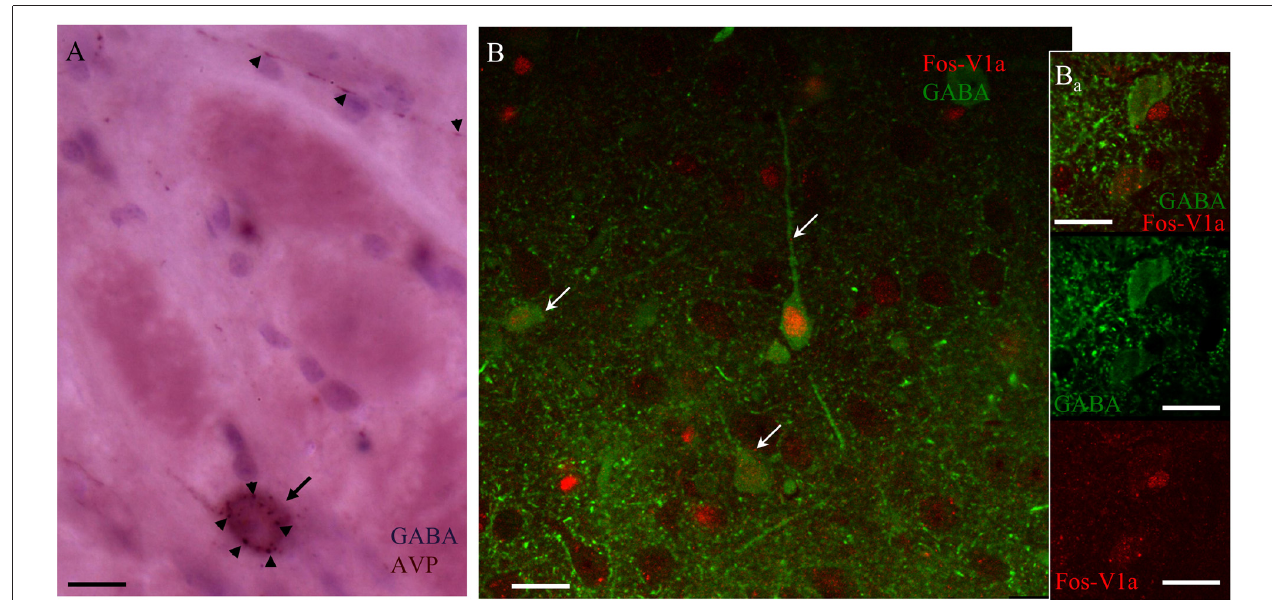
FIGURE 8 | AVP containing fibers in CeA synapse upon V1a receptor-positive GABAergic neurons activated after EPM. (A) Immunohistochemistry against AVP (arrowheads) and GABA (arrow) showing punctate AVP fibers terminals in close apposition with the GABA-labeled soma. (B) Confocal image of CeA immunoreacted against FOS (red nuclei indicated by arrows); V1a receptor (red punctuated label, indicated by arrowheads) and GABA (green cells). The immunohistochemistry was performed 90 min after the EPM in an animal infused with vasopressin in the CeA. (B a ) A different optical section of the same region showing two GABA+ neurons, one of them negative for V1a receptor showing no expression of Fos, the other one expressing the V1a receptor being Fos+. Scale bars: 10 µ